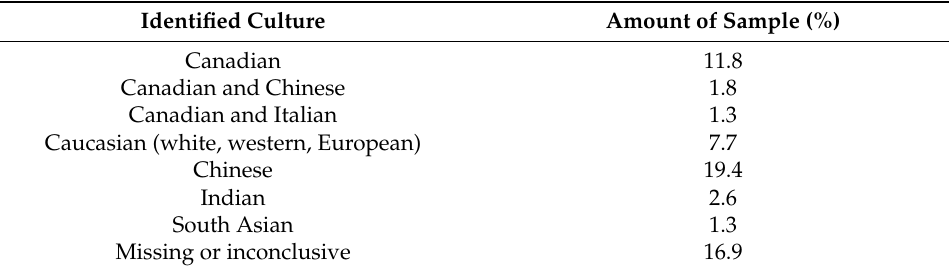
Table A1. Cultural Identifications Accounting for the Largest Percentages of